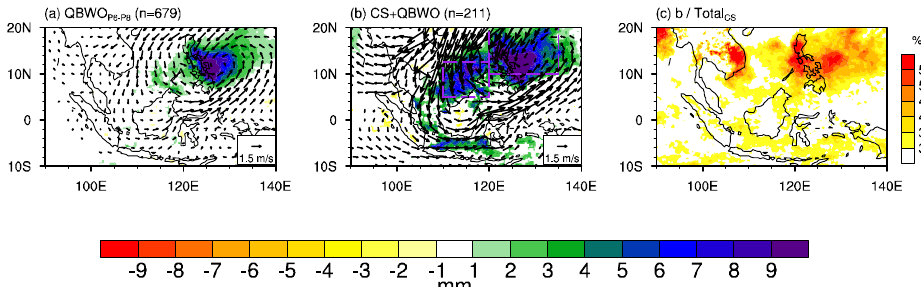
Figure 5. Composite anomalies of precipitation (shade, SI = 1 mm) and 925 hPa winds (vector, unit: 1.5 ms −1 ) during days ( a ) in phases 6–8 of the QBWO and ( b ) during days when the QBWO and cold surge co-exist. Number in left title represents the composite days. ( c ) is the ratio (shade, SI = 5%) of total precipitation in ( b ) to that during all cold surge days. Rectangles in ( b ) represent the regions over the EPH (10°–20°N, 120°–135°E) and NBO (5°–12.5°N, 110°–120°E), respectively. Values and vectors exceeding the 95% confidence levels based on the two-tailed Student’s t -test are shown in ( a , b ).